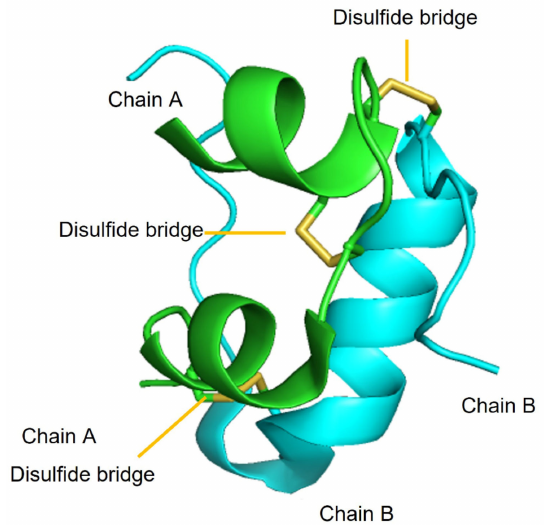
Figure 1. The three-dimensional structure of insulin shows three helical portions, two of chain A (green) and one of chain B (cyan), and three disulfide bridges